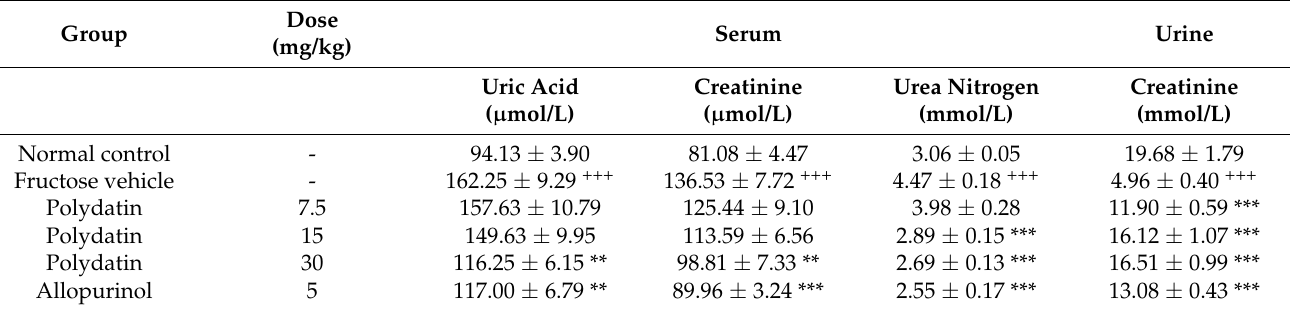
Table 2. Polydatin ameliorates kidney dysfunction in high fructose-fed rats.